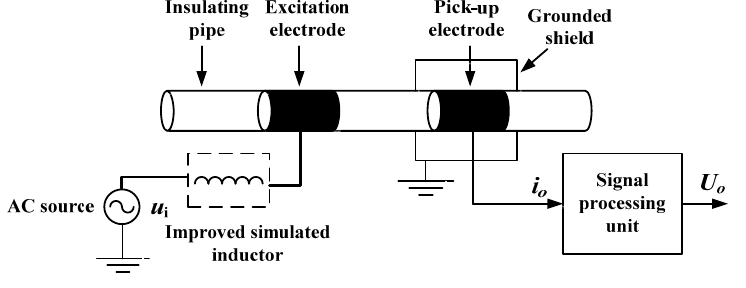
Figure 8. Construction of the supplementary C 4 D sensor.